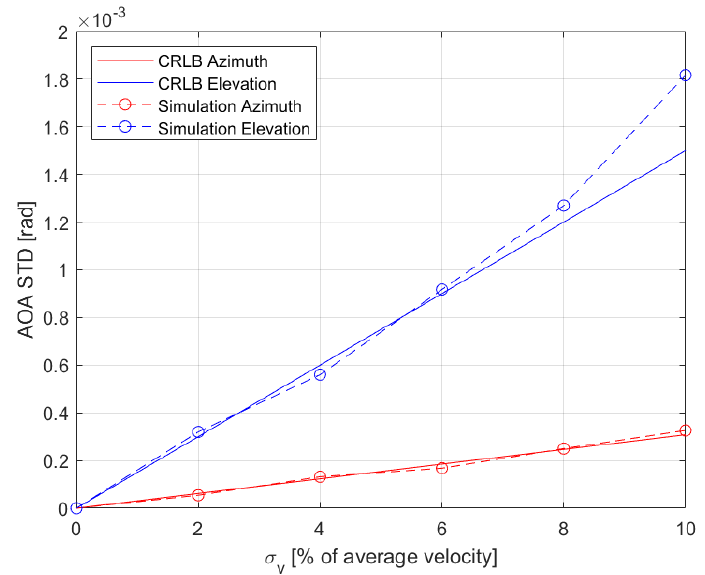
Figure 3. AOA standard deviation vs. velocity errors standard deviation. Elevation is shown in blue, azimuth in red, CRLB in solid lines, and simulations in dashed lines with the circle marker.